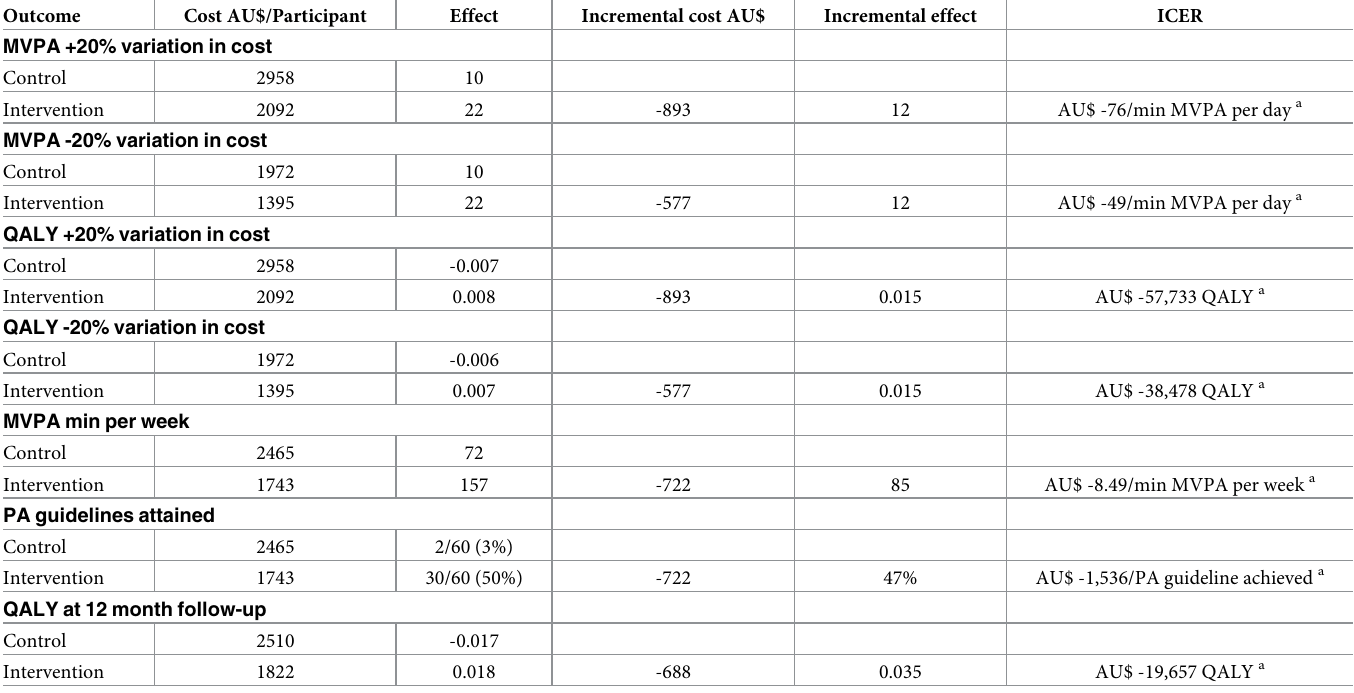
Table 4. Sensitivity analyses for costs, changes in outcomes and incremental cost-effectiveness ratios at